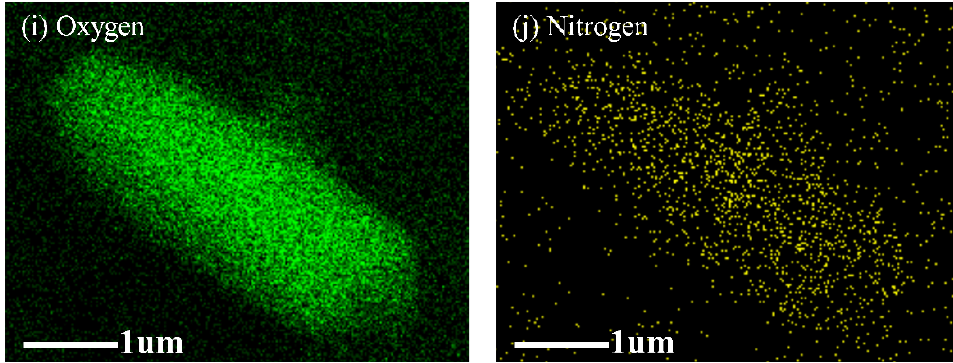
Figure 2. SEM image of MCDx catalysts: ( a ) MCD1; ( b ) MCD2; ( c ) MCD4; ( d ) MCD6; ( e ) EDS-Mapping of MCD6; ( f ) Element mapping of Manganese; ( g ) Element Mapping of Cerium; ( h ) Element Mapping of Carbon; ( i ) Element Mapping of Oxygen; ( j ) Element Mapping of Nitrogen.